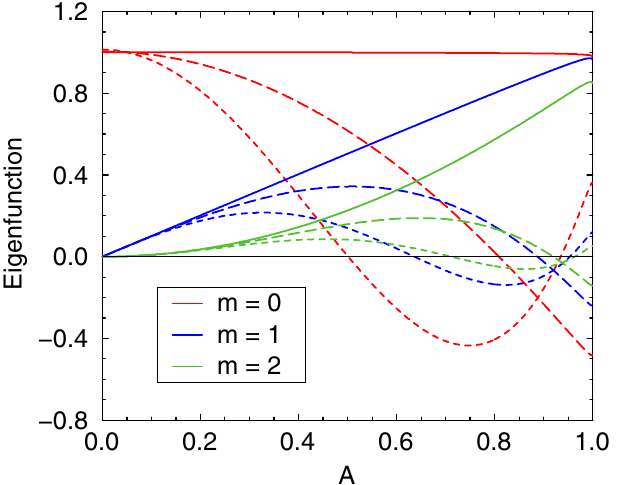
FIG. 10. (Color) Eigenfunctions of the boxcar bunch vs normal- ized synchrotron amplitude (uncoupled multipoles approach). Three radial modes are presented for each multipole.